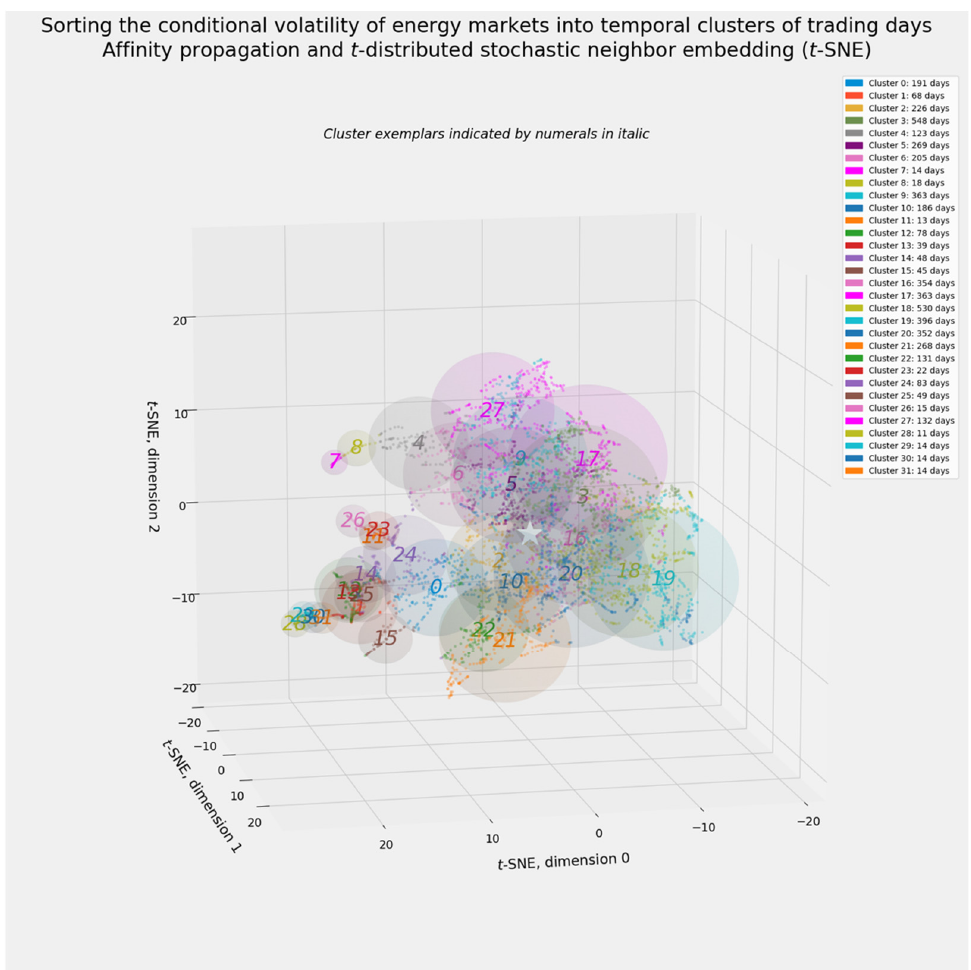
Figure 29. Affinity propagation of energy-related markets—A t -SNE manifold.